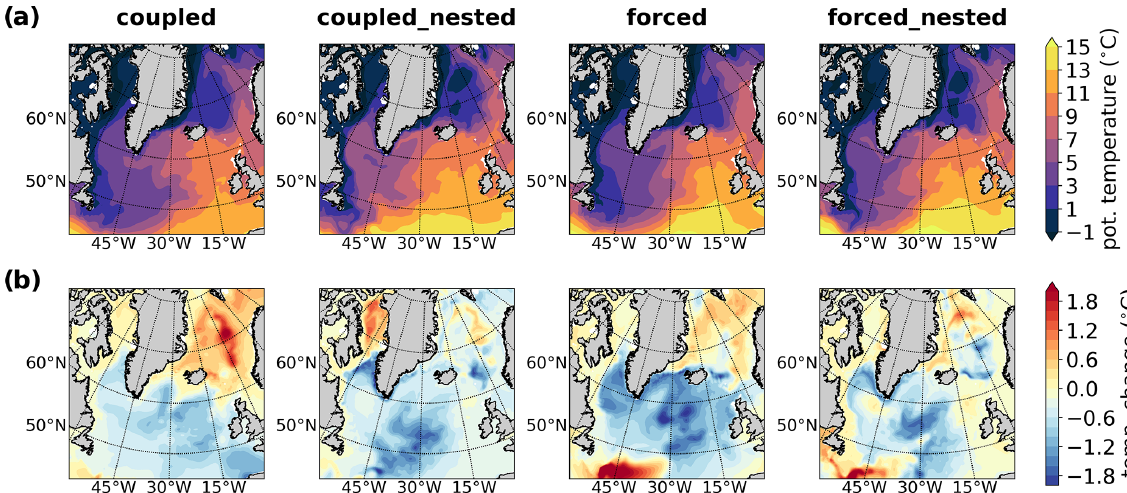
Figure 6. (a) Long-term mean state of upper-ocean (0–200m) annual-mean potential temperature and (b) the change in consequence of the freshwater perturbation. The response is computed as the difference in the means over years 51–100 and 43–62 in the coupled and forced cases, respectively.